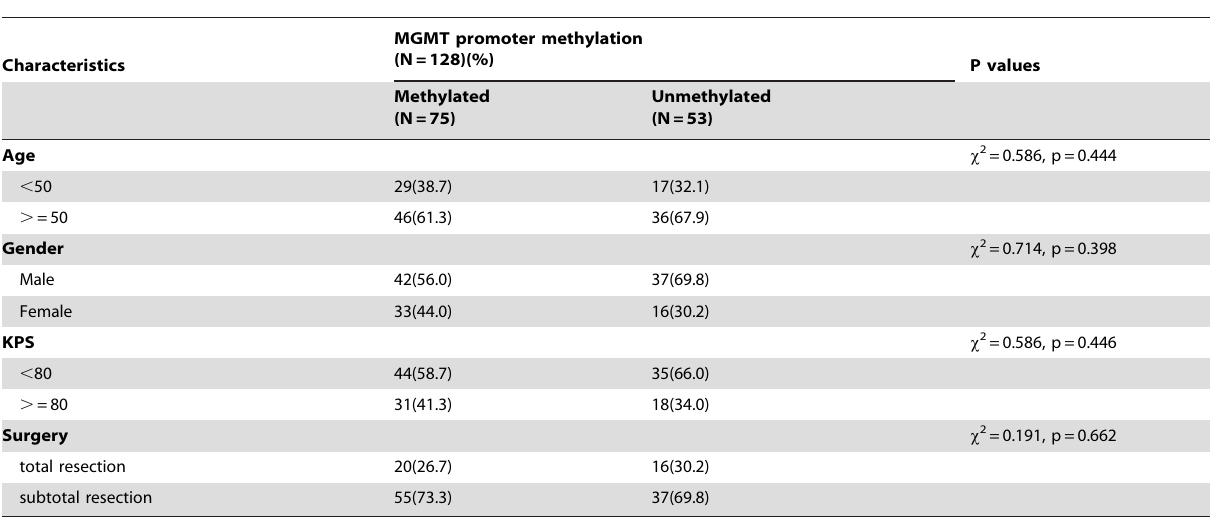
Table 1. Summary of glioblastoma patient characteristics.